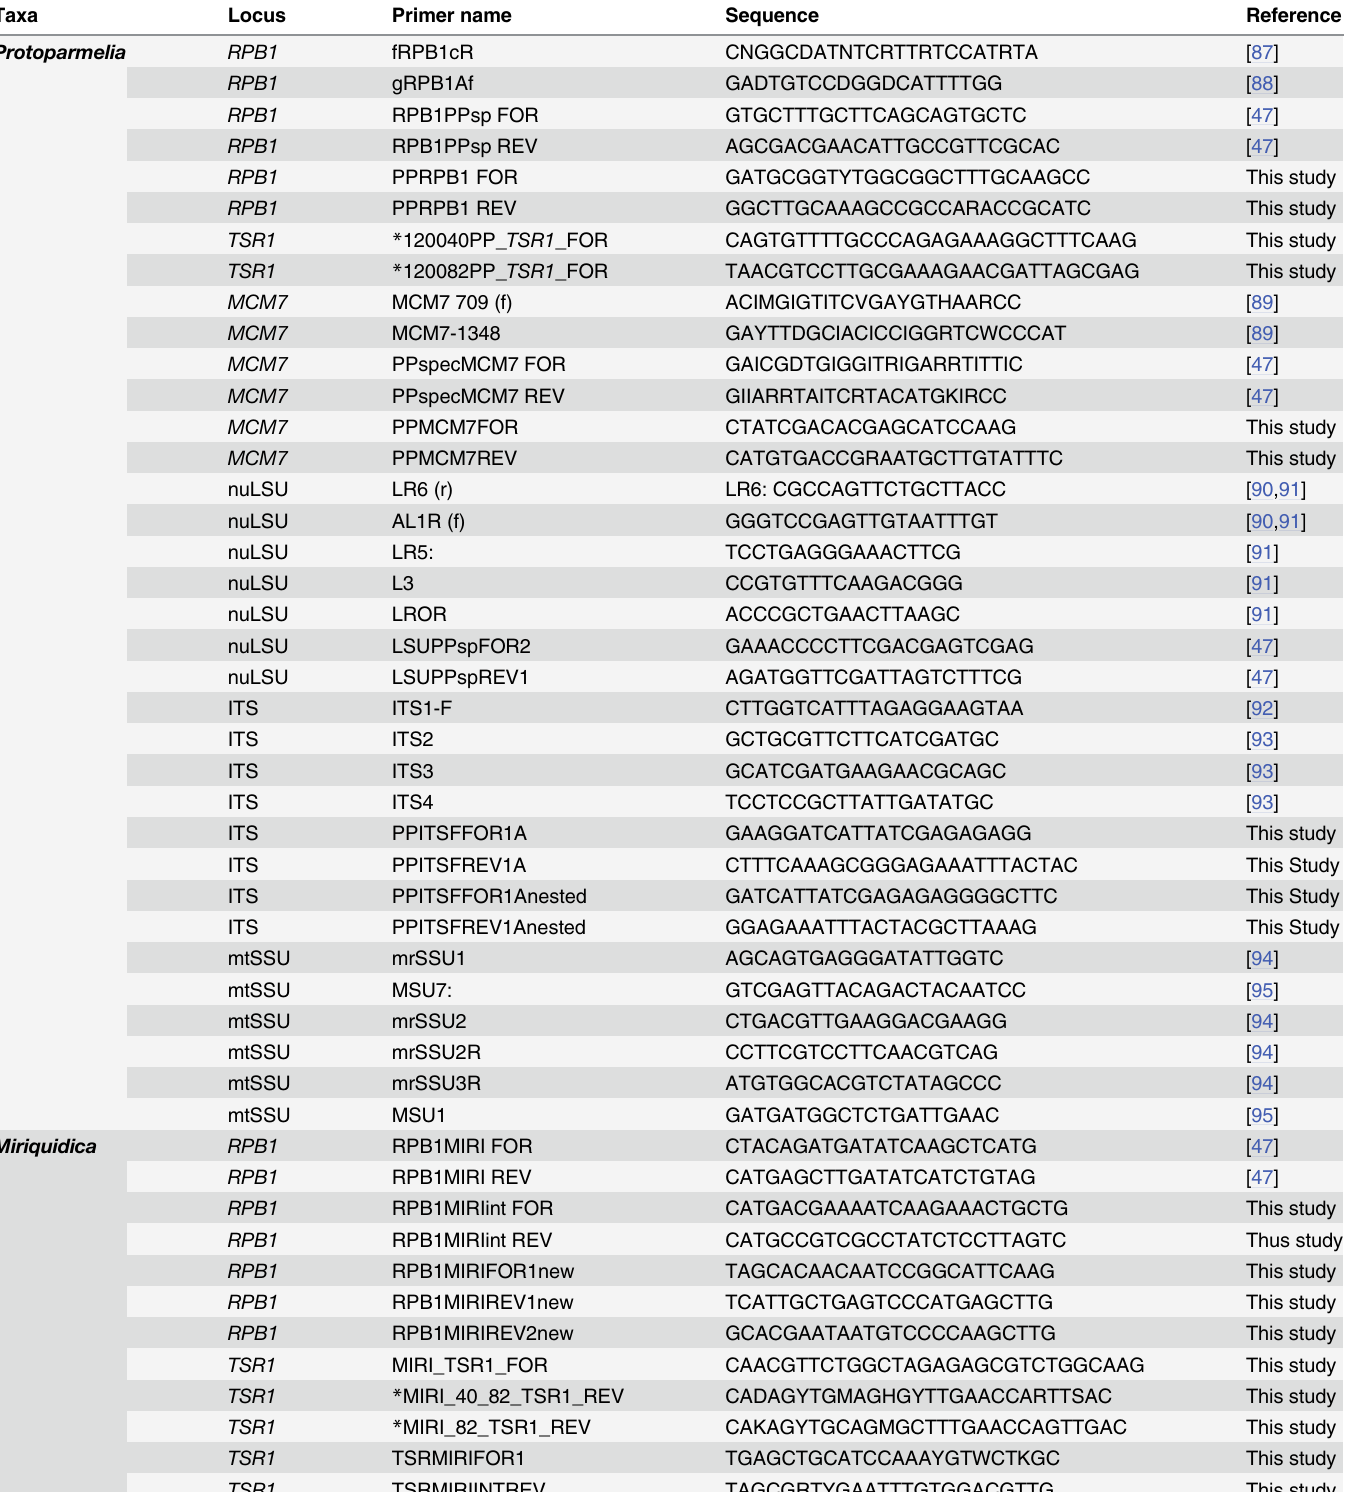
Table 1. Primers used in this study.